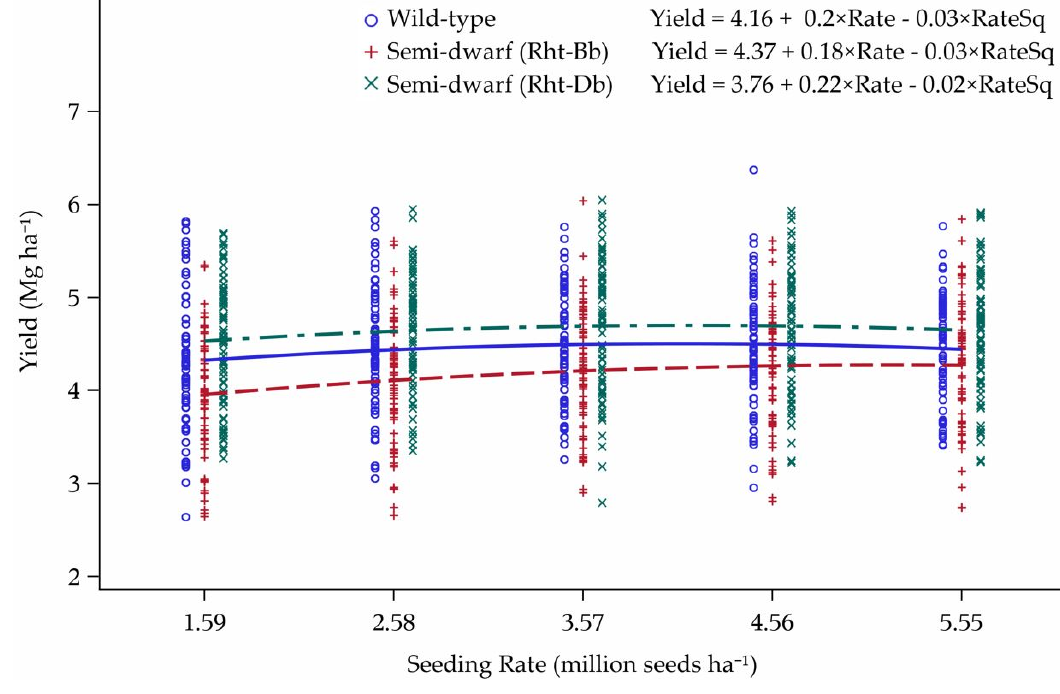
Figure 11. Influence of Rht-Bb , Rht-Db , and wild-type stature alleles on yield response to seeding rate over the six lowest-yielding environments in Minnesota and North Dakota, 2013–2015. Seeding rate for the peak of the curve: wild-type = 3.68, Rht-Bb = 3.75, and Rht-Db = 4.65 million seeds ha − 1